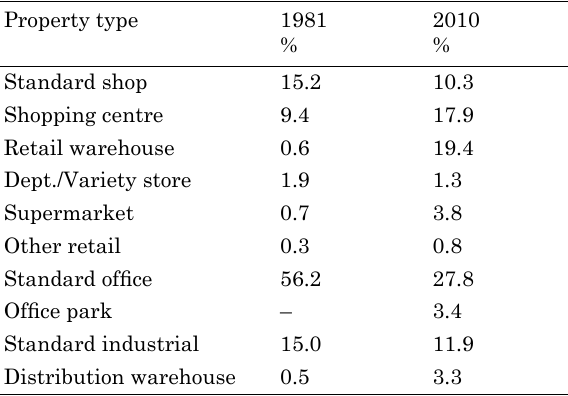
Table 1. Changing structure of the institutional portfolio 1981–2010 (source: IPD